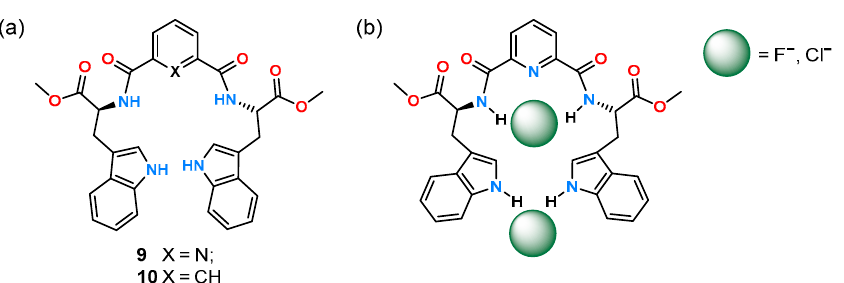
Figure 5. ( a ) Receptors 9 and 10 incorporating the tryptophan and indole moieties and ( b ) proposed 1:2 (receptor: anion) binding mode of receptor 9 with fluoride and chloride anions. While the isophthalic derivative 10 practically did not interact with the tested anions, receptor 9 formed complexes with stoichiometry 1:2 with chloride and fluoride anions and with an acetate complex with stoichiometry 1:1. Therefore, it was decided to continue affinity for the L enantiomer of the serine and alanine derivatives tested, and the chiral